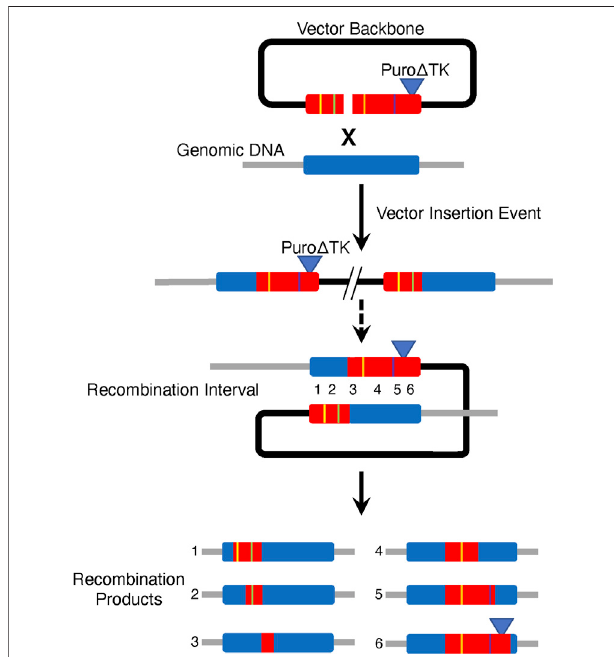
FIGURE8| StrategyforProducingMultipleRecombinantCellLinesfrom One Parental Vector Insertion Event Cell Line. Generation of multiple cell lines each containing different combinations of mutations could be generated from one parental vector insertion cell line using a multiply mutant targeting vector. In this example, product cell lines would generated by IHR across different recombination